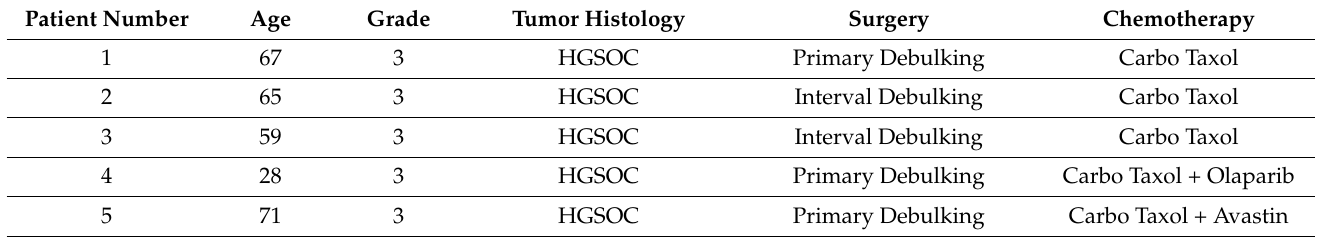
Table 2. Patients’ Characterization: Table contains patient numbers, age, grade, and tumor histol- ogy: HGSOC/high grade serous carcinoma, surgery—primary debulking, interval debulking ± HIPEC, or secondary debulking; chemotherapy—Carboplatin + Taxol ±